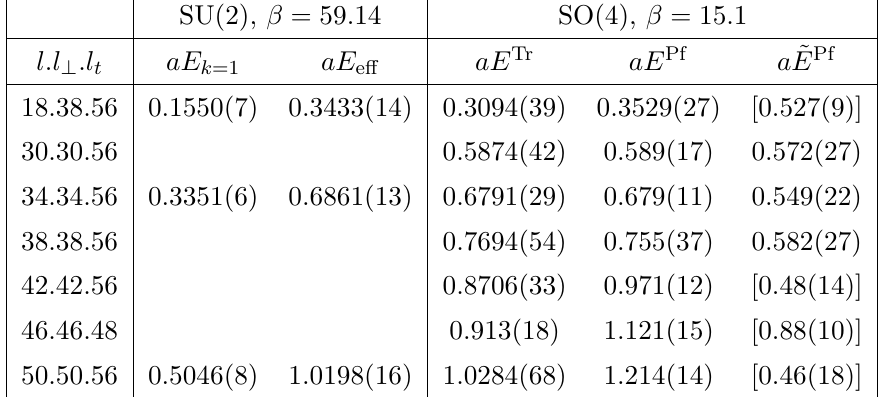
Table 9 . Energy of lightest (cid:13)ux loop of length l in the Trace and Pfa(cid:14)an sectors for SO(4) and in the fundamental for SU(2). E e(cid:11) is the energy the SU(2) (cid:13)ux loop would have if the string tension was twice as large. See text for explanation of Pfa(cid:14)an energies.